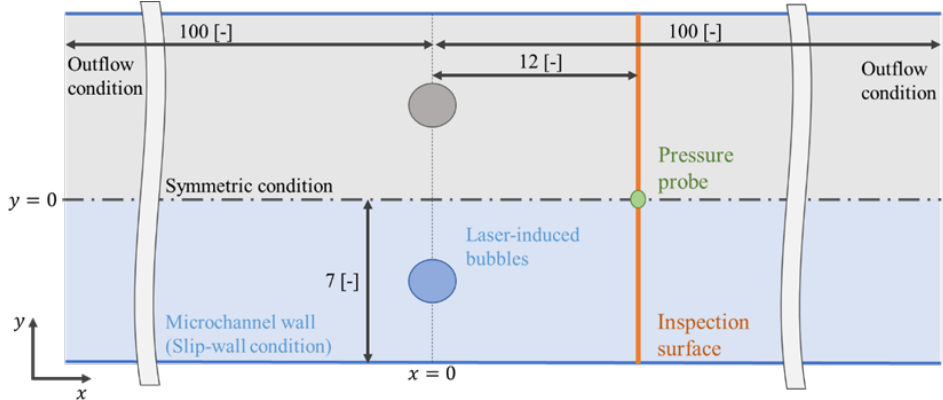
Figure 3. Simulation settings for the microchannel without meniscus and multiple laser-induced bubbles (w/o-meniscus setting). This figure shows the setting for the case of two bubbles. To measure the time history of the pressure, the pressure probe is placed at (12, 0). In